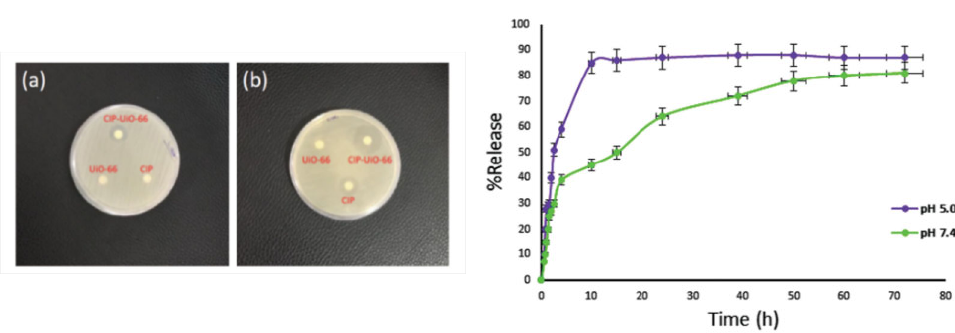
Figure 6. ( Left ): Disk diffusion studies on ( a ) S. aureus and ( b ) E. coli. ( Right ): pH-stimulated release of CIP from UiO-66. Reproduced with permission from [60].